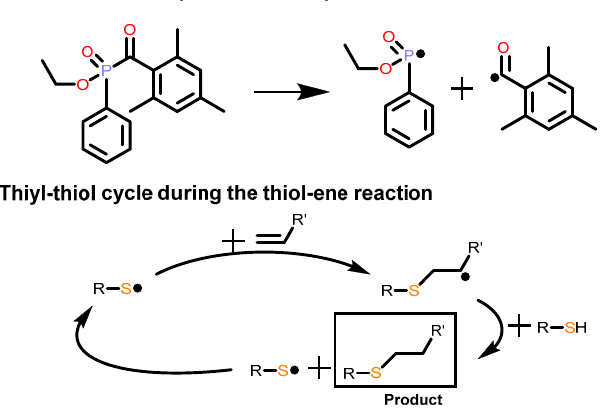
Scheme 2. Schematic representations of the decomposition of the photoinitiator ( top ) and the